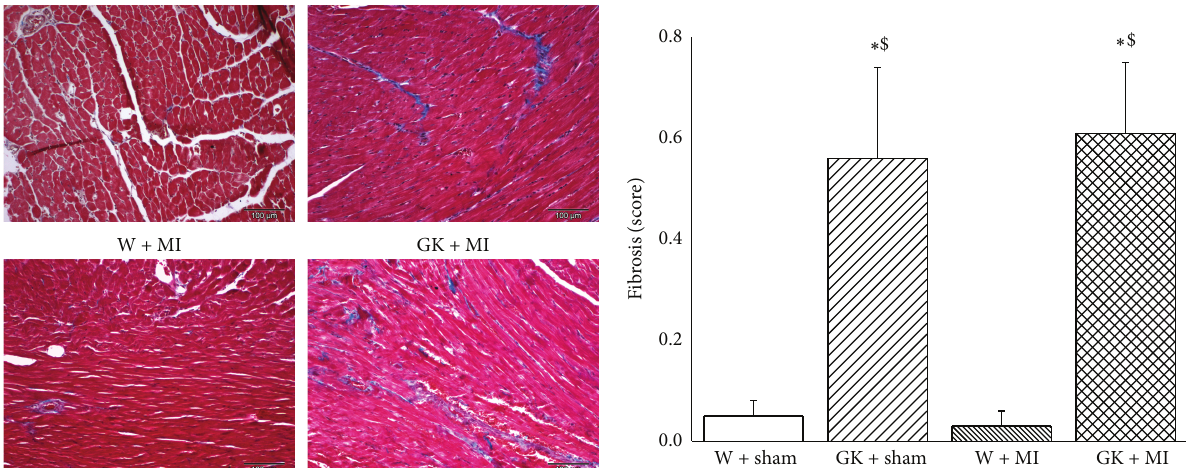
Figure 2: Histological analysis (Masson’s trichrome staining). Histological examination of the myocardium stained with Masson’s trichrome (magnification × 100, scale bar: 100 𝜇 m). Data is presented as mean ± SEM. ∗ 𝑃 < 0.05 versus W; # 𝑃 < 0.05 versus GK; $ 𝑃 < 0.05 versus W + MI. MI indicates myocardial infarction; GK: Goto-Kakizaki; W: Wistar. Masson’s trichrome staining (grade 0 indicates normal tissue showing no fibrotic region; grade 1 indicates mild fibrosis; grade 2 indicates moderate fibrosis, and grade 3 indicates severe